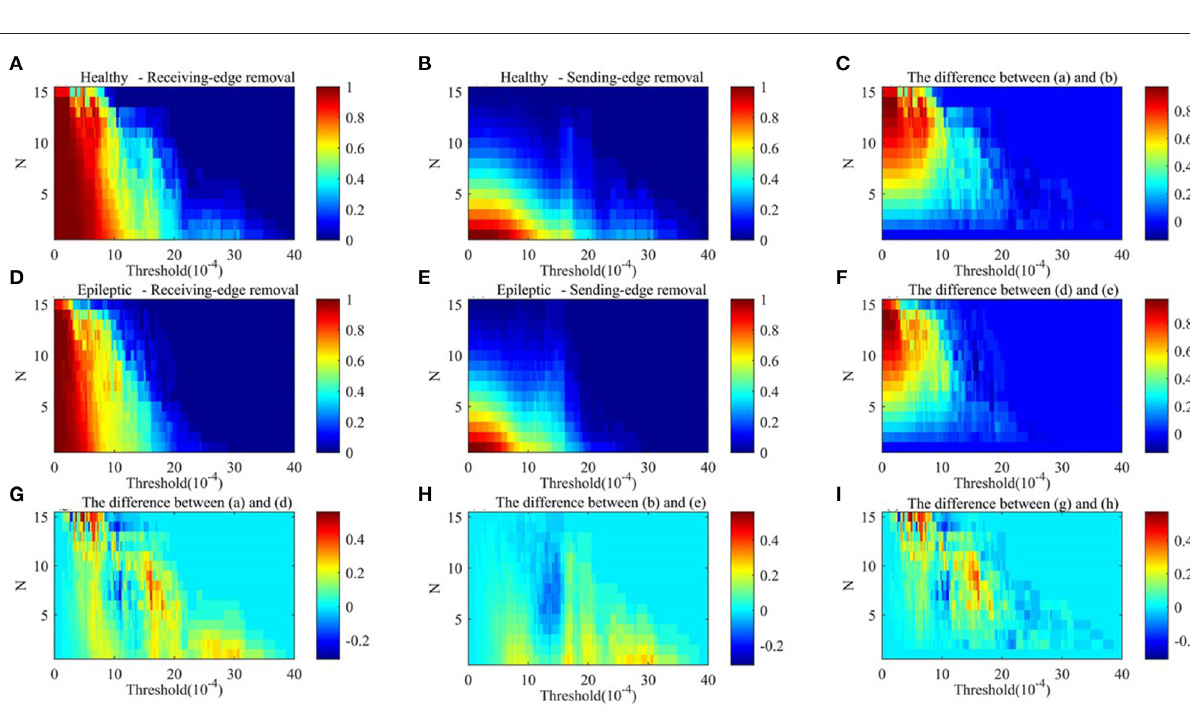
Frontiers in Neuroscience |